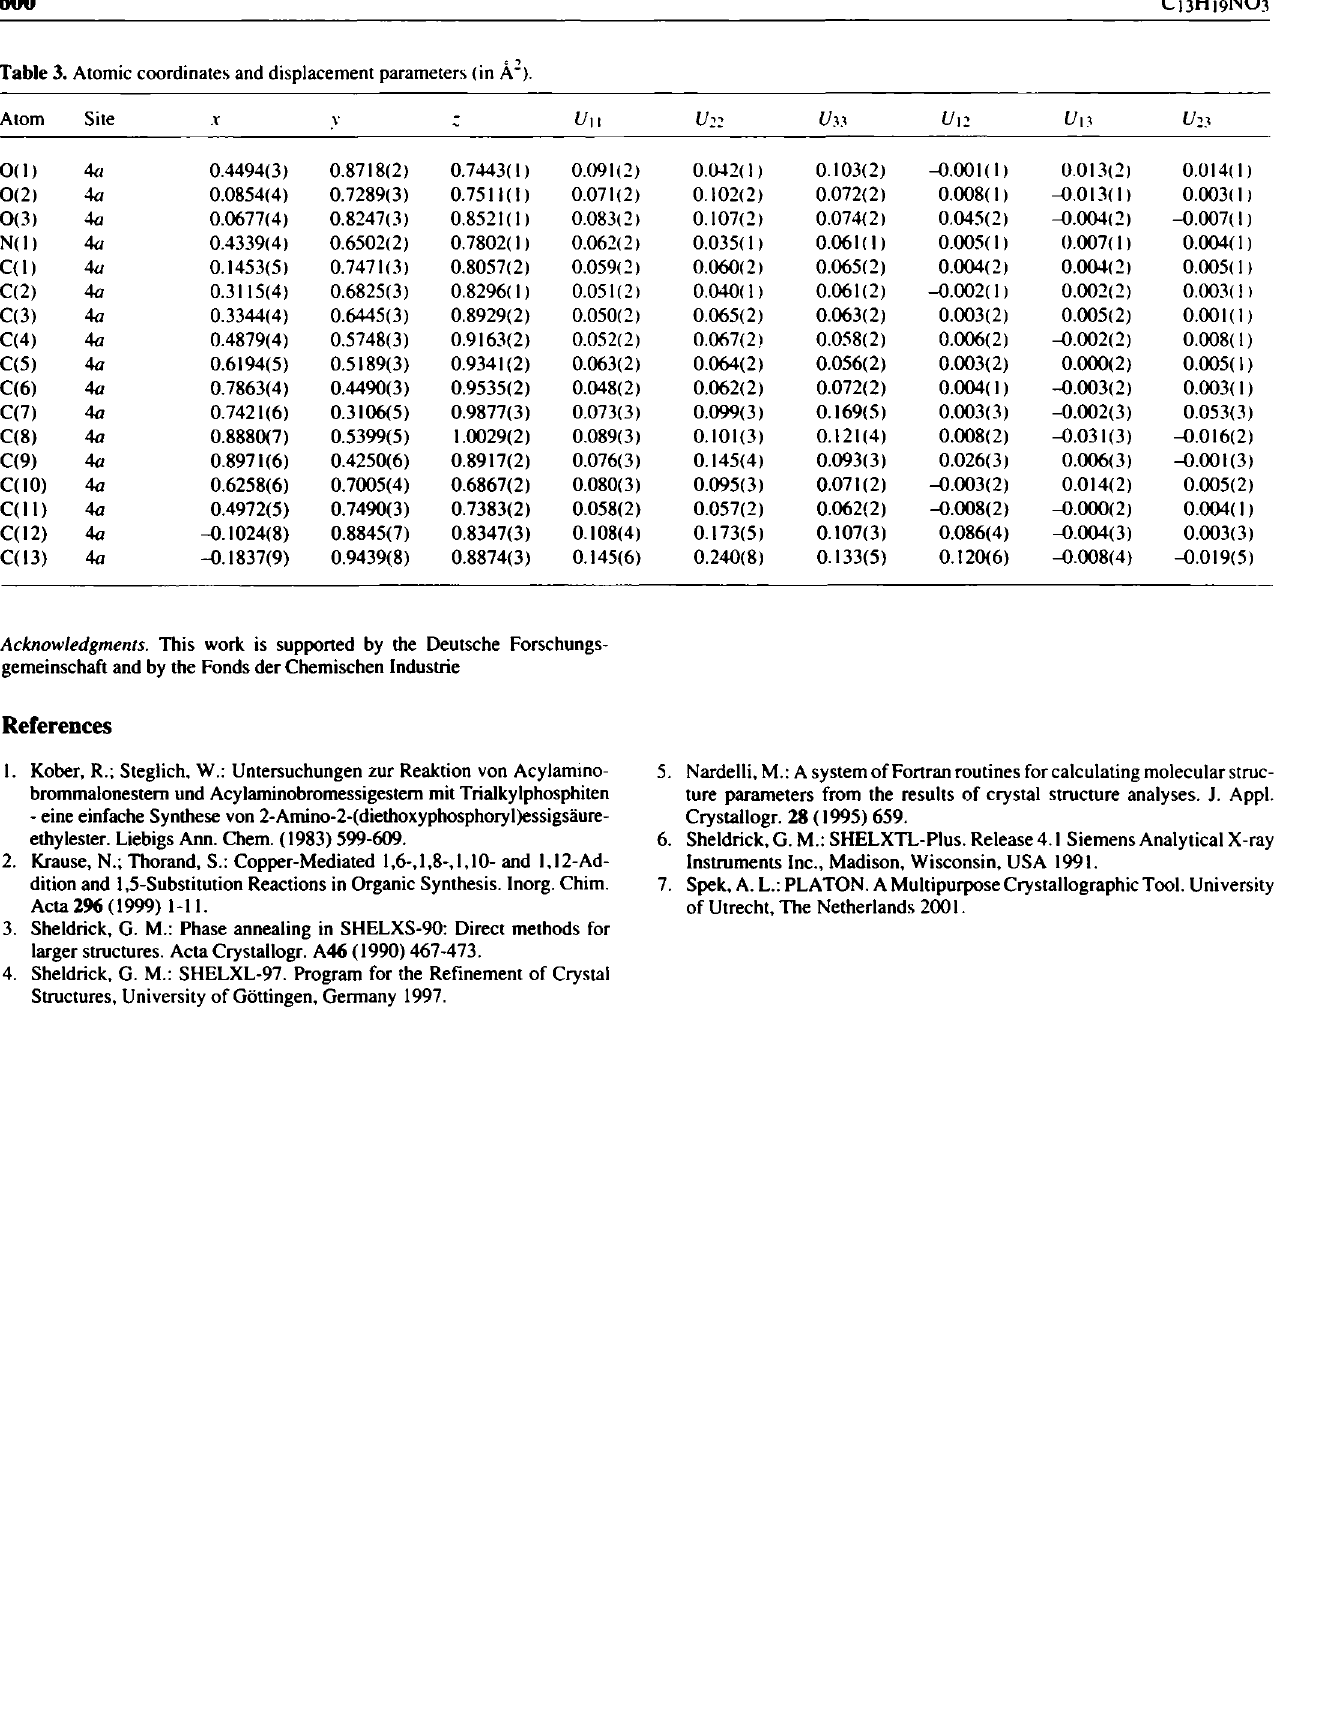
Table 3. Atomic coordinates and displacement parameters (in